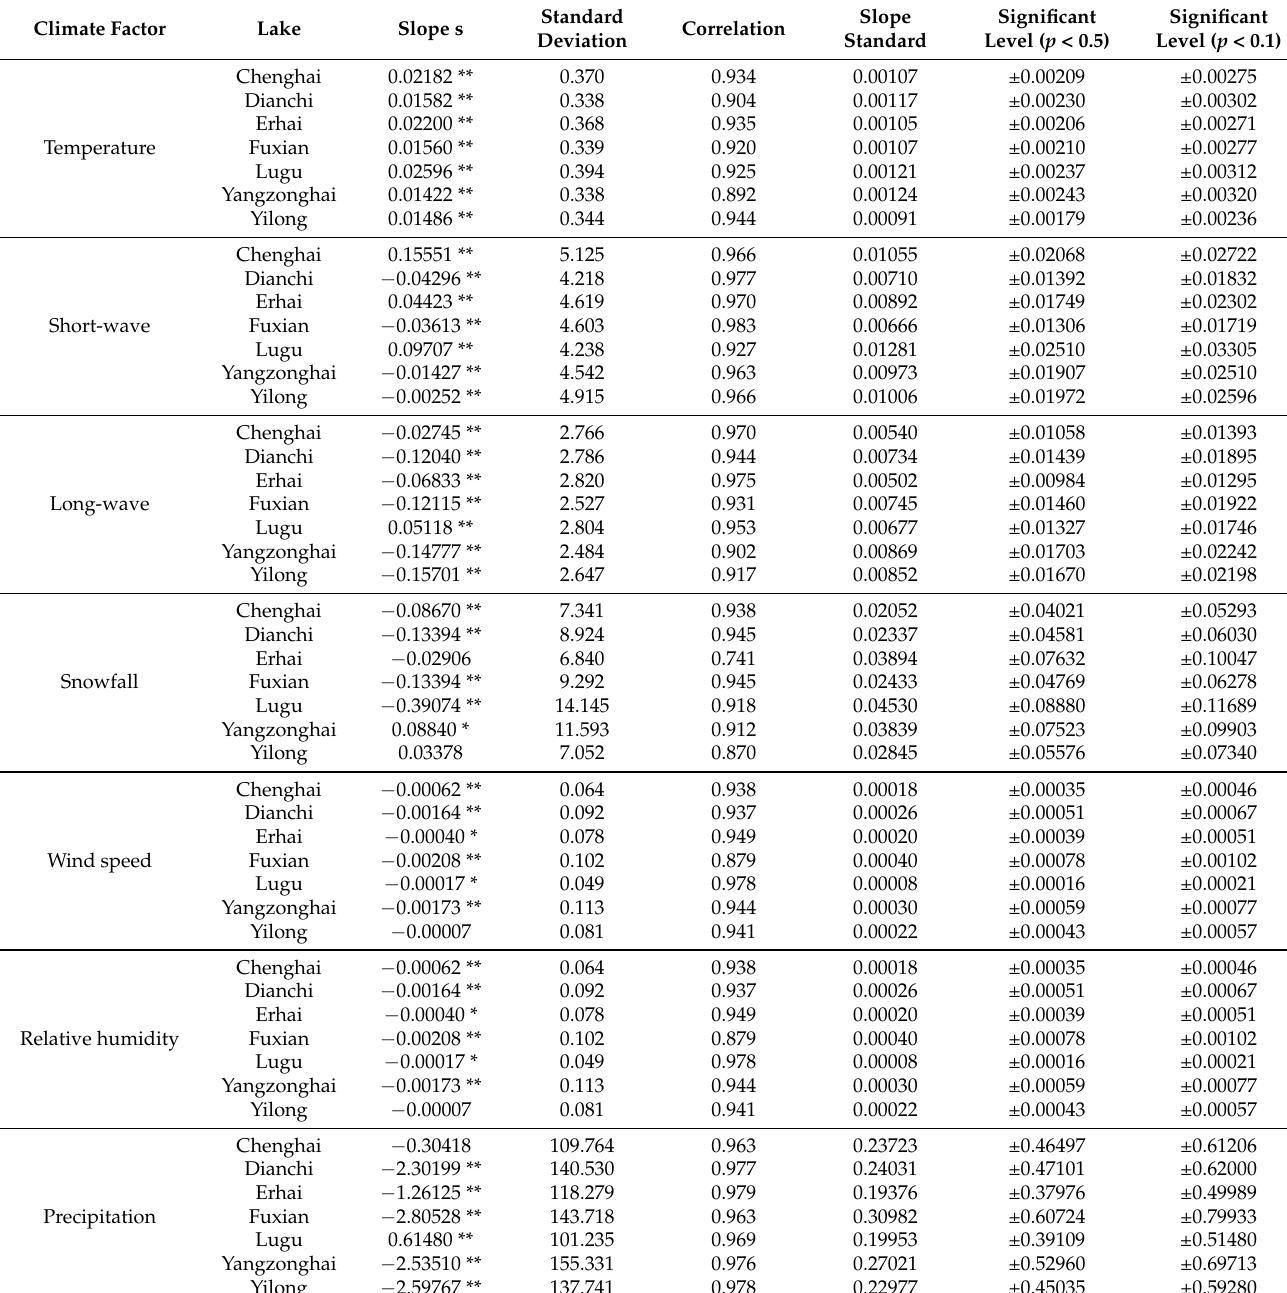
Table 2. Results for innovation trend analysis of the annual mean values of climatic factors of lakes on the Yunnan